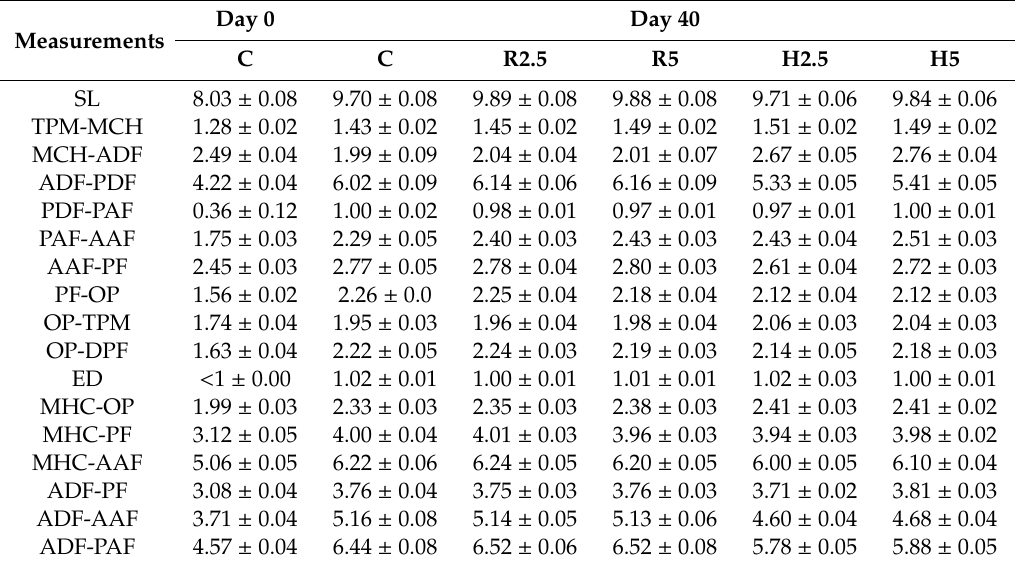
Table 5. Morphological traits of gilthead seabream at day 0, and after feeding the experimental diets over 40 days. Measurements